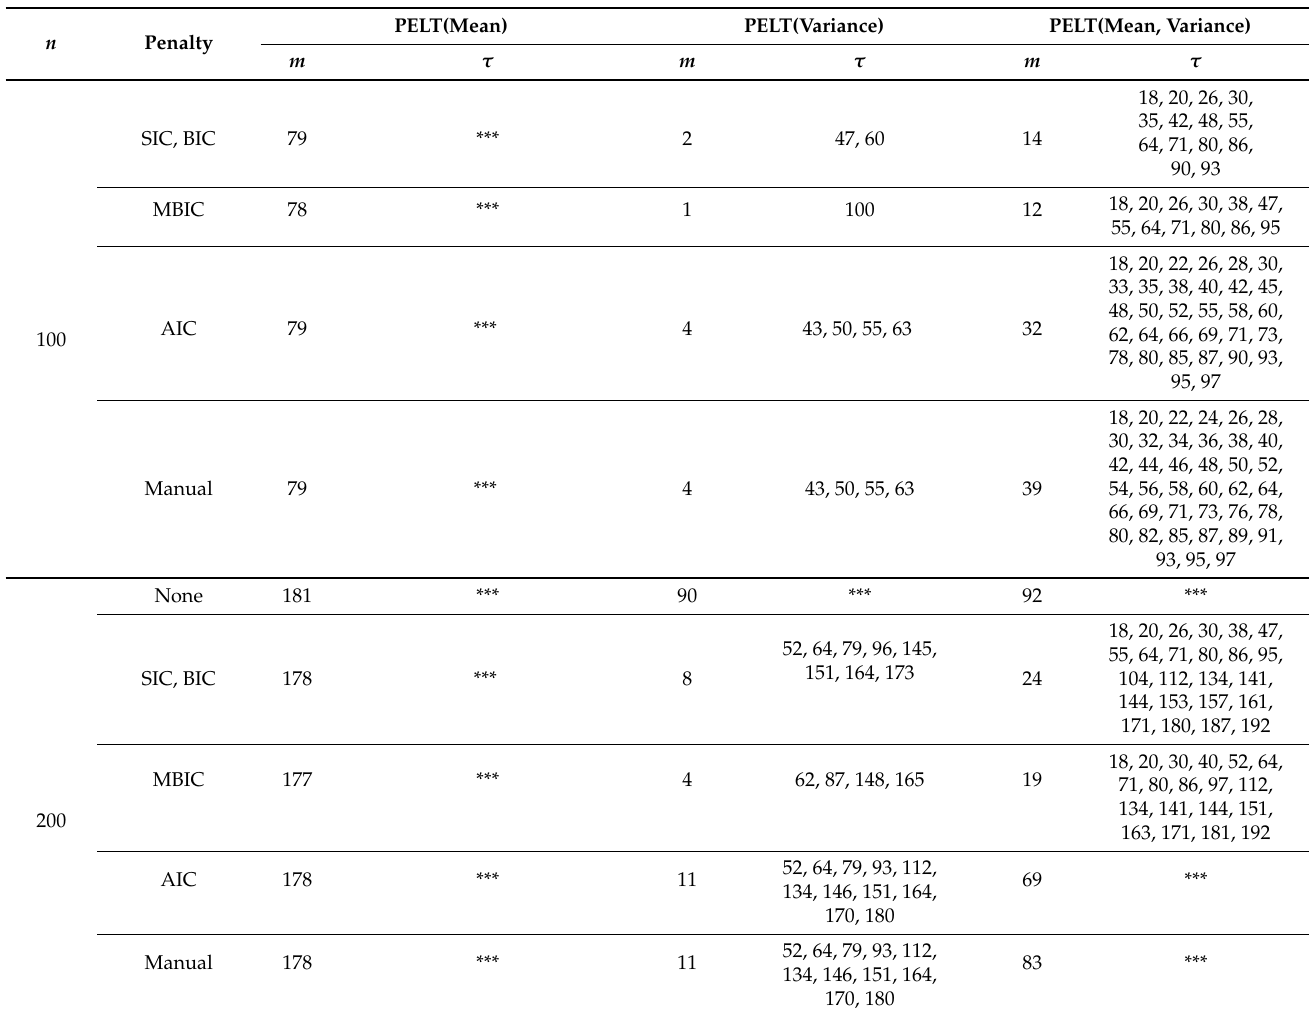
Table A14. PELT Algorithm Result for Poland’s COVID-19 Daily